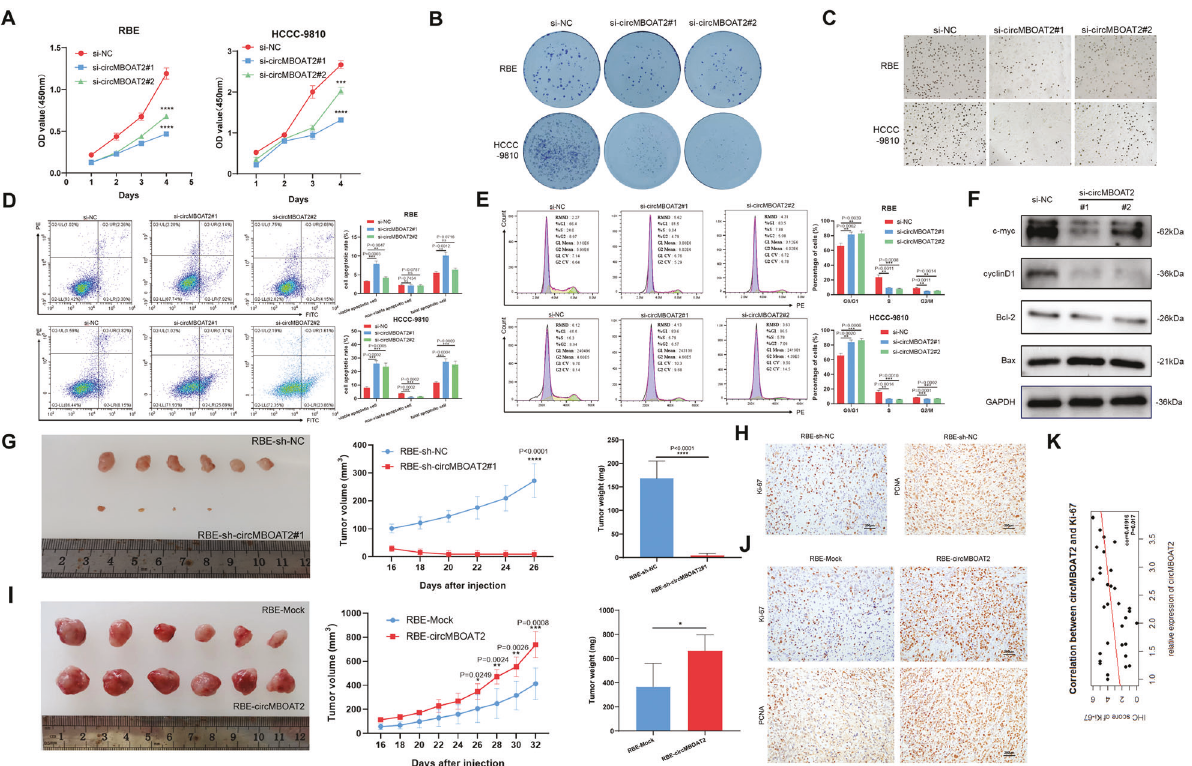
Fig. 2 CircMBOAT2 promotes ICC progression in vitro and in vivo. A CCK8 assay for cell proliferation capacity. The results showed that the downregulation of circMBOAT2 inhibited the viability of RBE and HCCC-9810 cells. B Clone formation assay. The results showed that silencing circMBOAT2 inhibited the proliferative capacity of RBE and HCCC-9810 cells. C 5-Ethynyl-2 ’ -deoxyuridine (EdU) proliferation assay. Knockdown of circMBOAT2 inhibits DNA synthesis in RBE and HCCC-9810 cells. The original magni fi cation was 200×. D Data are expressed as the early and late stages of apoptosis rate after si-NC, si-circMBOAT2#1, or si-MBOAT2#2 transfection of RBE and HCCC-9810 cells. E The percentage cell phase distribution including G0/G1, S, and G2/M phases after transfection of RBE and HCCC-9810 cells with si-NC, si-circMBOAT2#1 or si- MBOAT2#2. F The expression of ICC progression-related proteins in circMBOAT2-knockdown ICC cells was detected by western blot. G , I The volume and weight of subcutaneous xenograft tumors ( n = 6 mice per group). H , J The expression of Ki67 and PCNA by IHC staining. K Correlation between the expression of circMBOAT2 and Ki67 by Pearson correlation analysis. The original magni fi cation was 200×. Signi fi cant differences between groups were analyzed by t -test. Error bars represent the means ± SEM of three independent